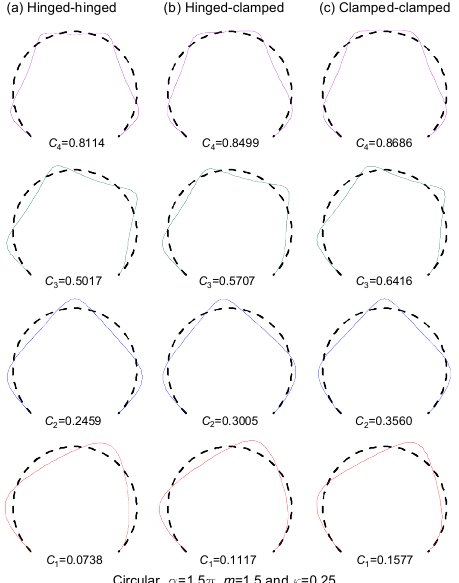
Figure 8. (cid:1829) (cid:3036) versus (cid:2018) curves. Figure 8. C